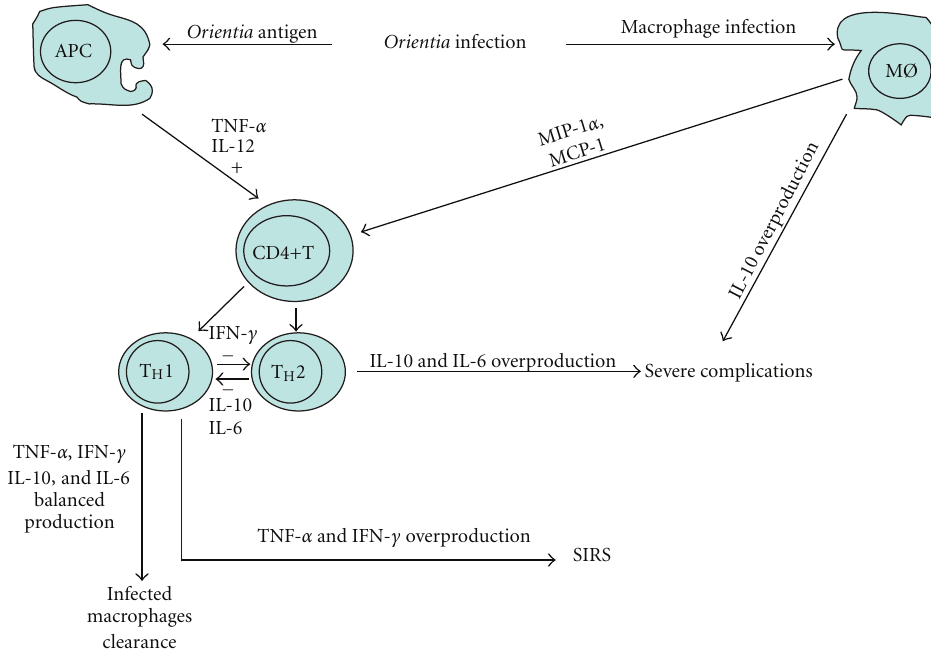
Figure 10: T lymphocytes and related cytokines in oriential